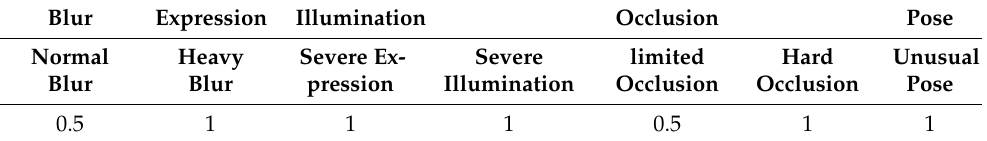
Table 1. Assigning difficulty values: a strategy.